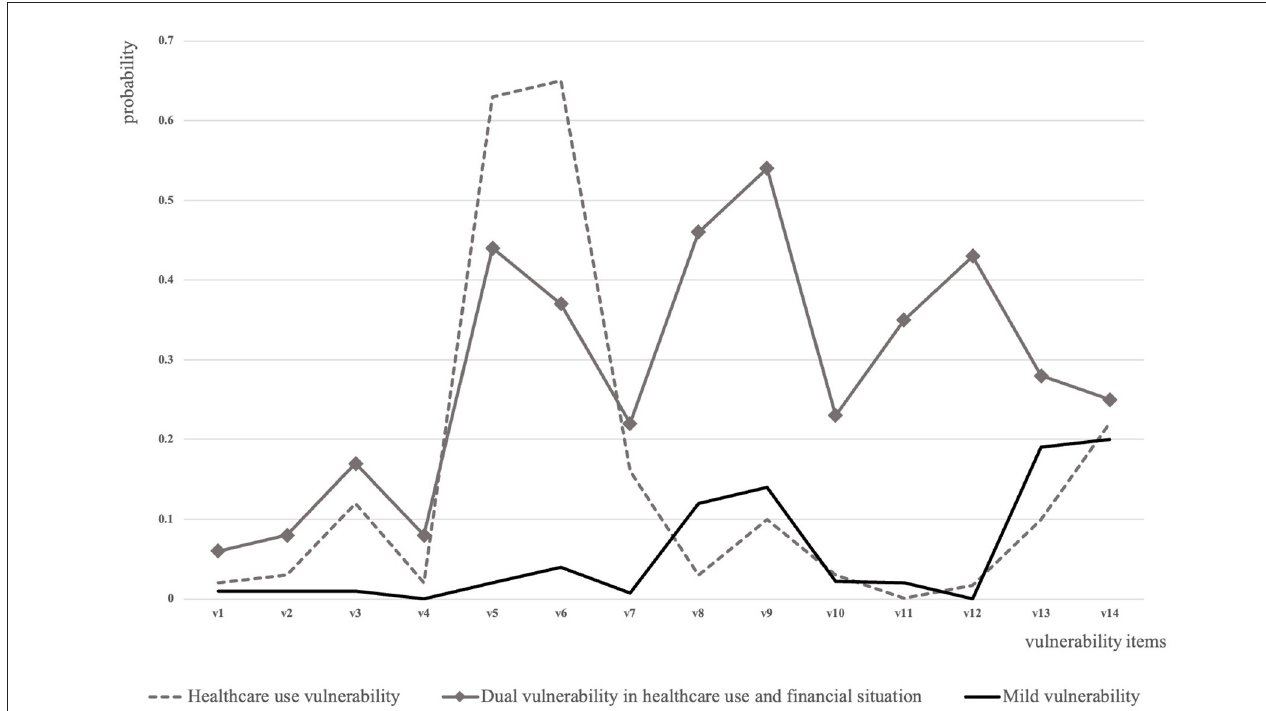
FIGURE 1 | Vulnerability groups detected among older adults in the United States during the COVID-19 pandemic. Notes: The vulnerability type was determined by the estimated probability of respondents from each latent class answering yes to vulnerability items. The solid black line refers to the group with mild vulnerability; the dotted line refers to the group with healthcare use vulnerability; and the solid line with square marks refers to the group with dual vulnerability in healthcare use and financial sustainment. Vulnerability items are as follows: v1: had been diagnosed with the COVID-19; v2: had a household member been diagnosed with